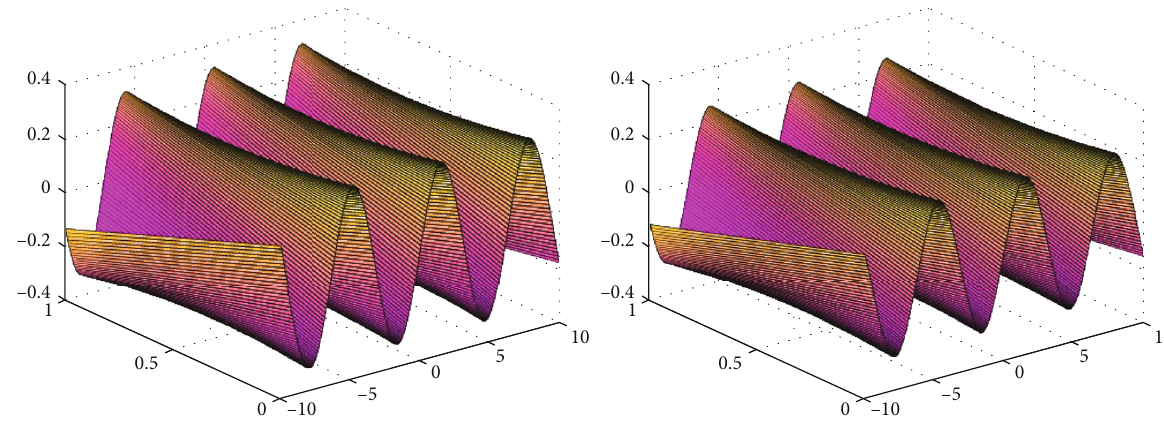
Figure 8: The fractional order of α = 0 : 8 and 0 : 6 of Problem